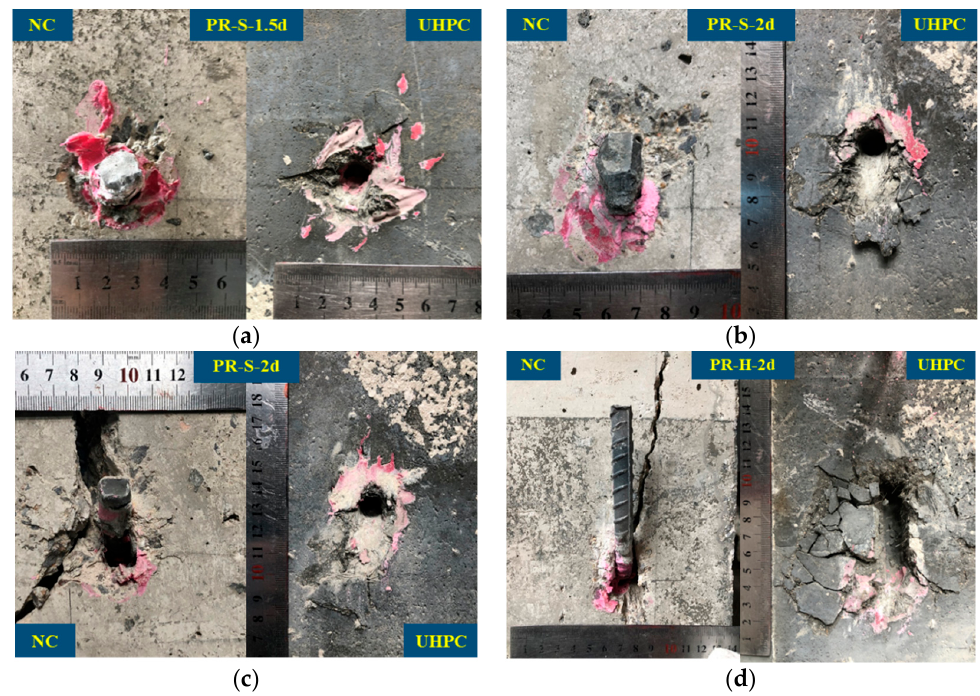
Figure 5. Details of rebar pulled out from UHPC. ( a ) PR-S-1.5d-2; ( b ) PR-S-2d-2; ( c ) PR-S-2d-3; ( d ) PR-H-2d-2.